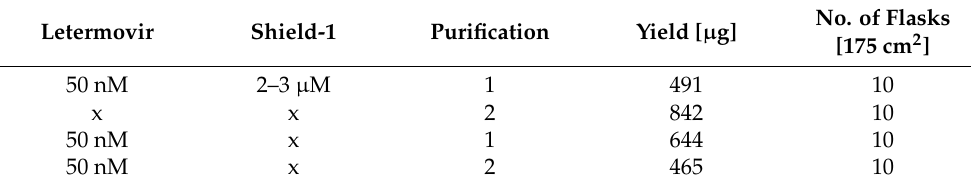
Figure 8. TR-VAC DB production with HFF. ( a , b ) Ultracentrifugation gradients of producer cell supernatants showing the fractions of non-infectious enveloped particles (NIEPs), virions, and DB that were that were released from HFF, infected with TR-VAC and grown without Shield-1 and either with ( a ) or without ( b ) LMV. The fractions corresponding to the different fractions are indicated. ( c ) SDS-polyacrylamide gel and silver nitrate staining for the analysis of the DB-fractions from ( a , b ). In addition, TR-VAC DB purified from HFF and cultured with both LMV and Shield-1 (left lane) and Towne-UL130rep-UL25ms DB cultured without addition of LMV or Shield-1 (right lane) were analyzed as control. The protein bands were visualized by staining with silver nitrate. Table 1. Yield of TR-VAC DBs following gradient ultracentrifugation.